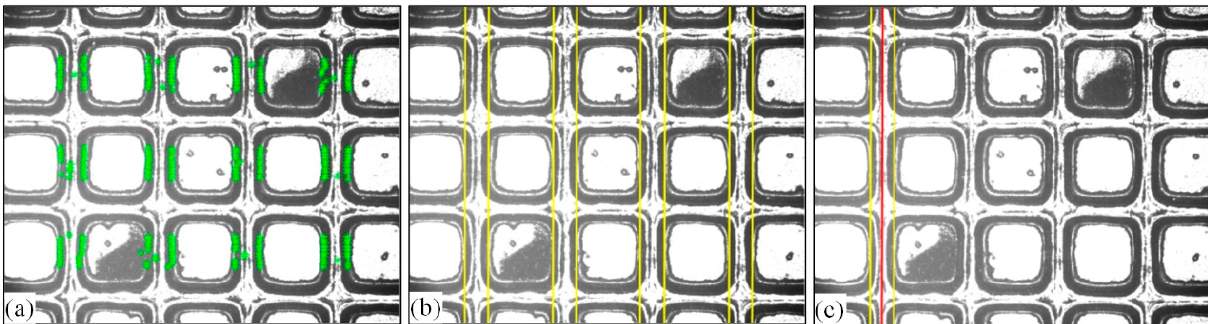
Figure 9. The result of each step of the cutting path. ( a ) The interlayer in the chip region; ( b ) straight lines; ( c ) cutting path.